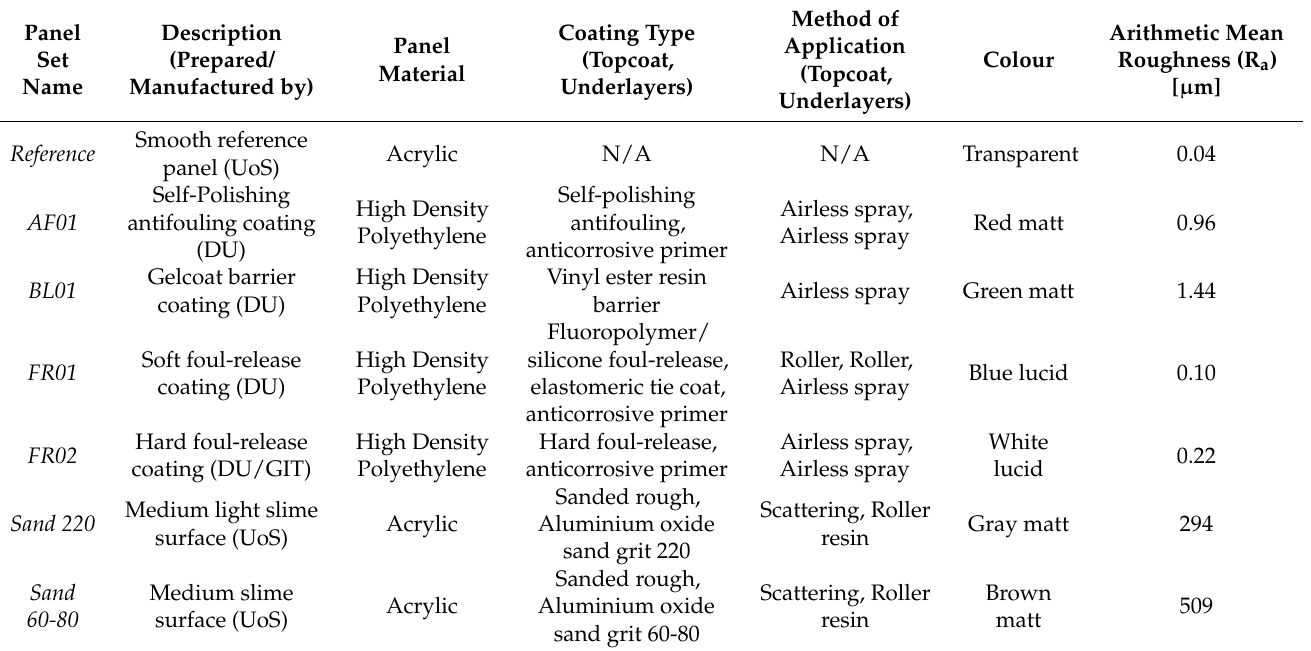
Table 3. Overview of each test panel set. Similar test surfaces can be found in